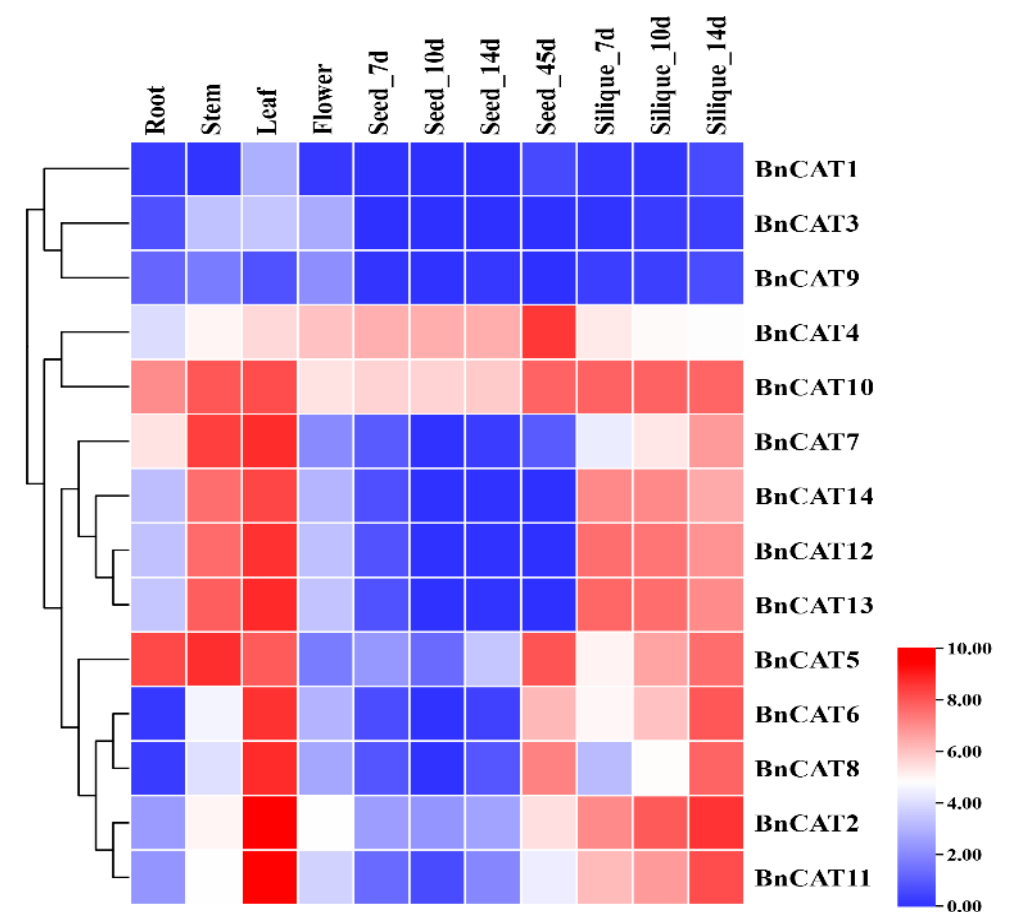
Figure 7. Expression patterns of BnCAT genes in various tissues at different growth phases of rapeseed. The 7d, 10d, 14d, and 45d labels showed the time-points when the samples were harvested. In the expression bar, the red color shows high, and the blue color shows low expression levels.